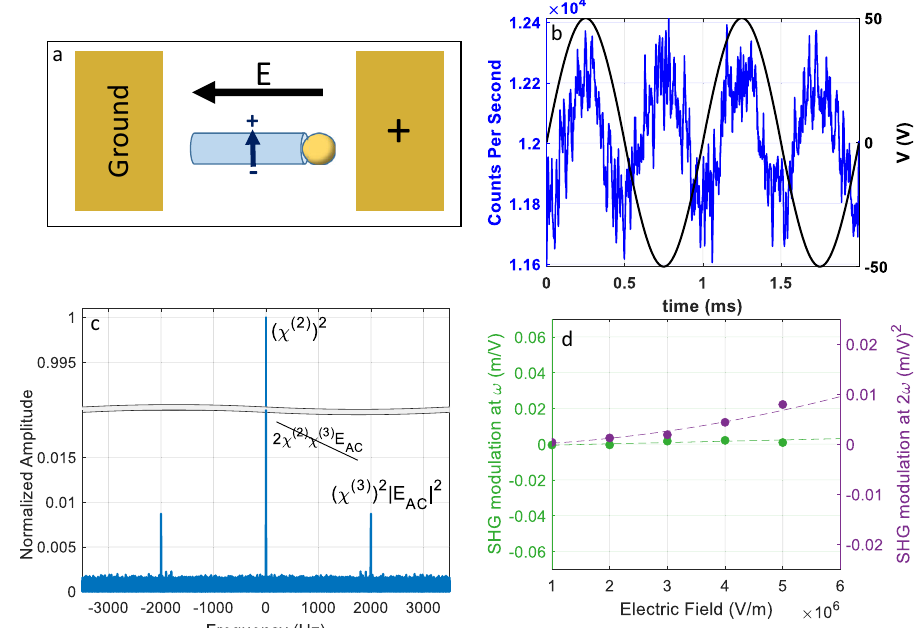
Fig. 4 EFM-SHG from a nonpolar nanowire. a A scheme of a nonpolar nanowire between two electrodes. The c -axis of the ZnO crystal (blue) is perpendicular to the nanowire ’ s growth axis and to the external electric fi eld (black). b Applied AC voltage (black) and the time-averaged optical SHG signal (blue) from a nonpolar nanowire showing oscillations at a double frequency. c FFT spectrum of the EFM-SHG. The frequency of the oscillating electric fi eld is 1 kHz. Optical response is observed at 2 kHz. d Amplitude of the signal at 1 kHz (within the noise level) (green) and 2 kHz (purple) from the FFT spectrum as a function of the calculated electric fi eld magnitude. SHG modulation at ω and 2 ω is presented in the same scale as in Fig.